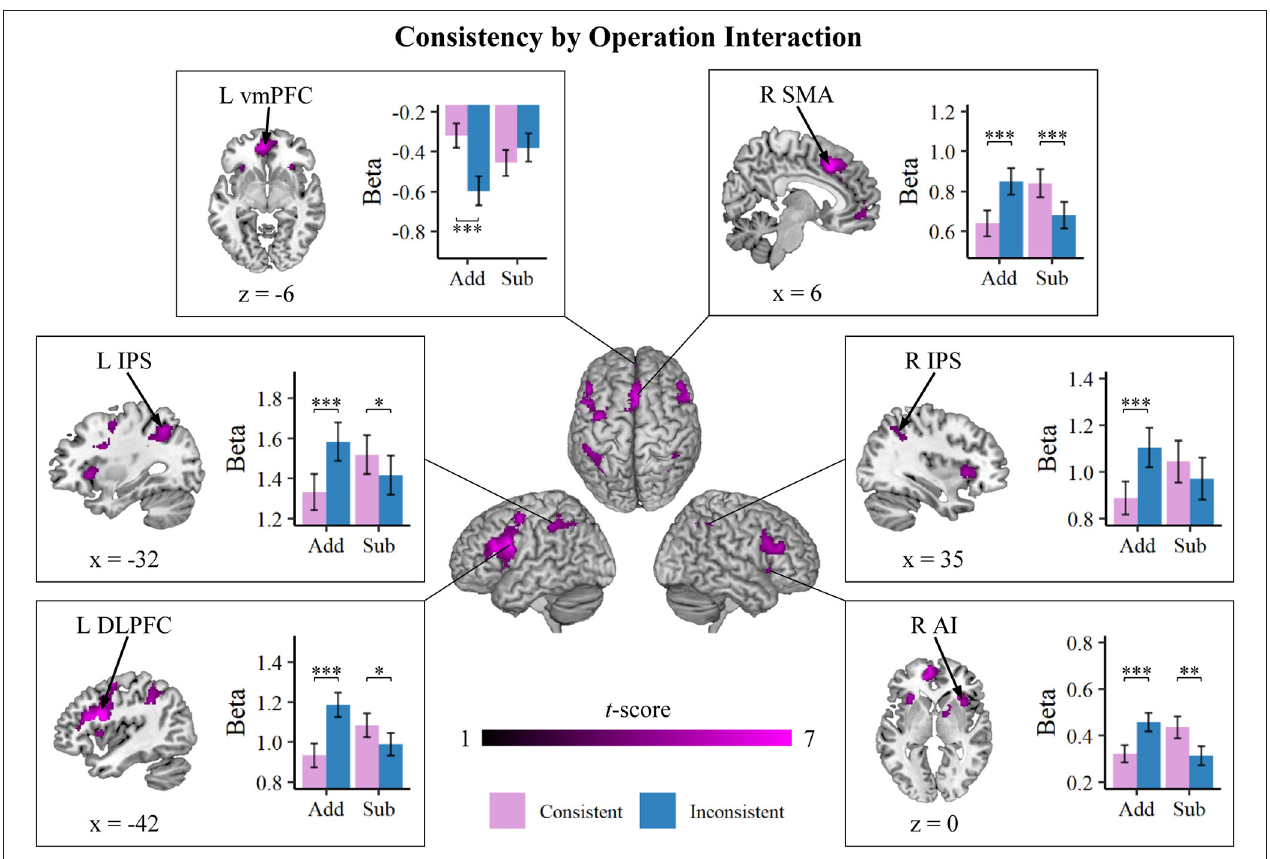
FIGURE 3 | Brain regions that showed an interaction between consistency and operation. Inconsistent problems revealed stronger activations than consistent problems for addition (Add), whereas for subtraction (Sub), consistent problems were associated with greater activations than inconsistent problems. These effects manifested in the widespread fronto-insular-parietal network, including the anterior insula (AI), supplementary motor area (SMA), ventromedial prefrontal cortex (vmPFC), the bilateral dorsolateral prefrontal cortex (DLPFC), and the bilateral intraparietal sulcus (IPS). Error bars represent standard errors. * p < 0.05, ** p < 0.01, *** p <